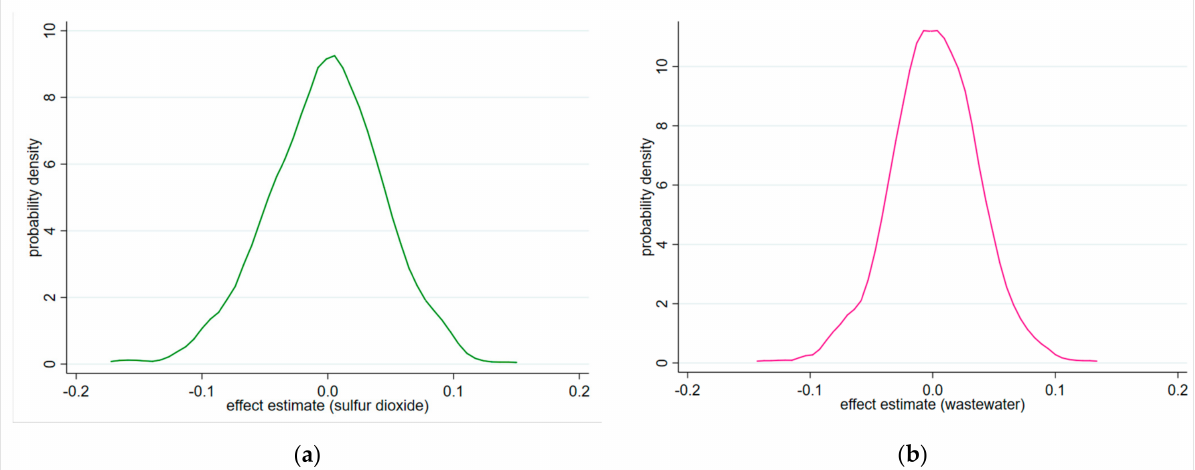
Figure 4. Distribution of estimated coefficients of placebo test. Note: ( a , b ), respectively, show the cumulative distribution density of the estimated coefficients of ln ( SO 2 ) and ln ( wastewater ) is from 500 simulations randomly assigning the policy status to cities.